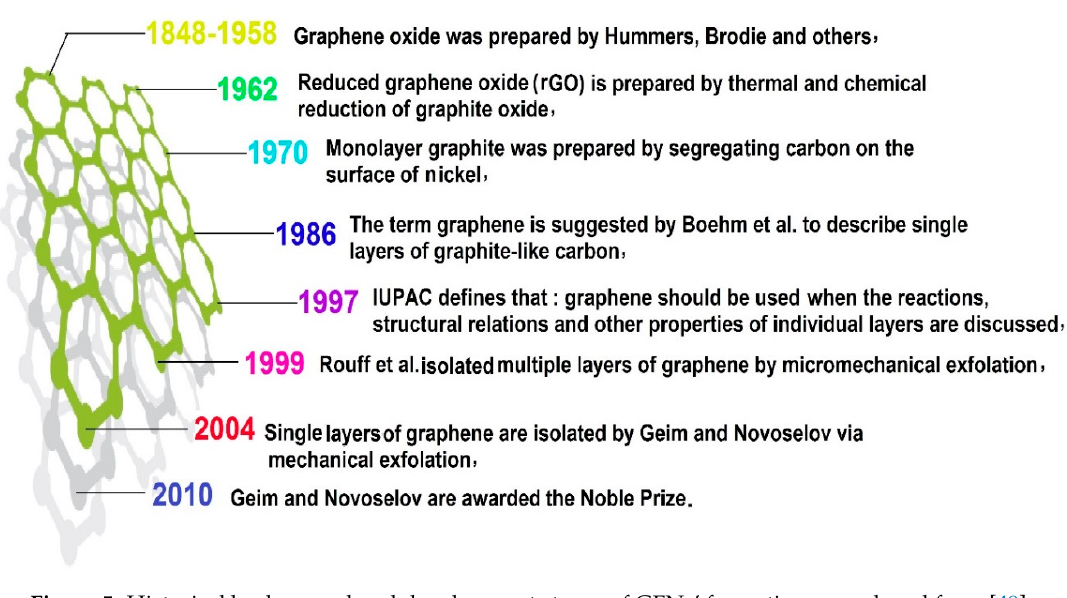
Figure 5. Historical background and development stages of GFNs’ formation reproduced from [49], with permission from Elsevier, 2017.